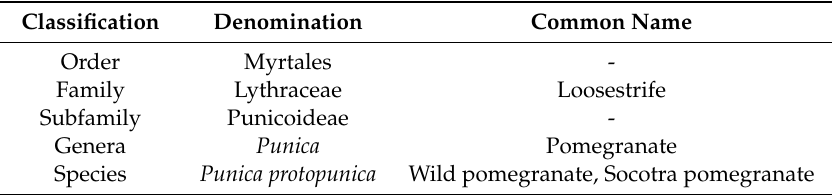
Table 1. Taxonomic positioning of Punica protopunica